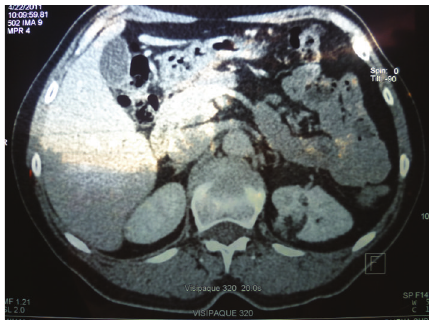
Figure 4: Six months after the rupture of the right renal angiomy- olipoma, the complete resolution of the hematoma was observed, with normal renal parenchyma. The enlargement of the left adrenal gland (adenoma) was also